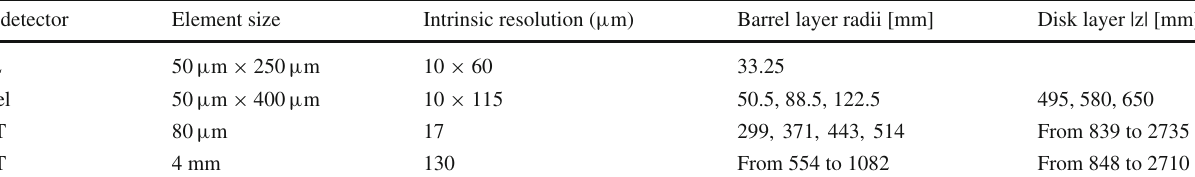
is given [1,11]. For SCT and TRT the element size refers to the spacing of the read-out strips and the diameter of the straw tube, respectively